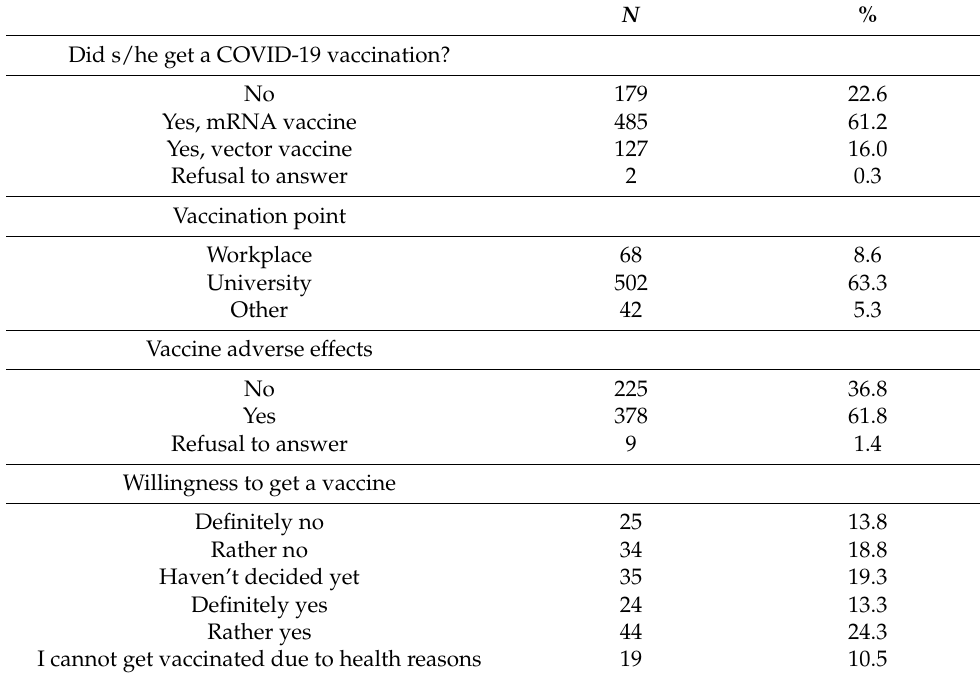
Table 2. COVID-19 vaccination: Implementation, procedure, and first